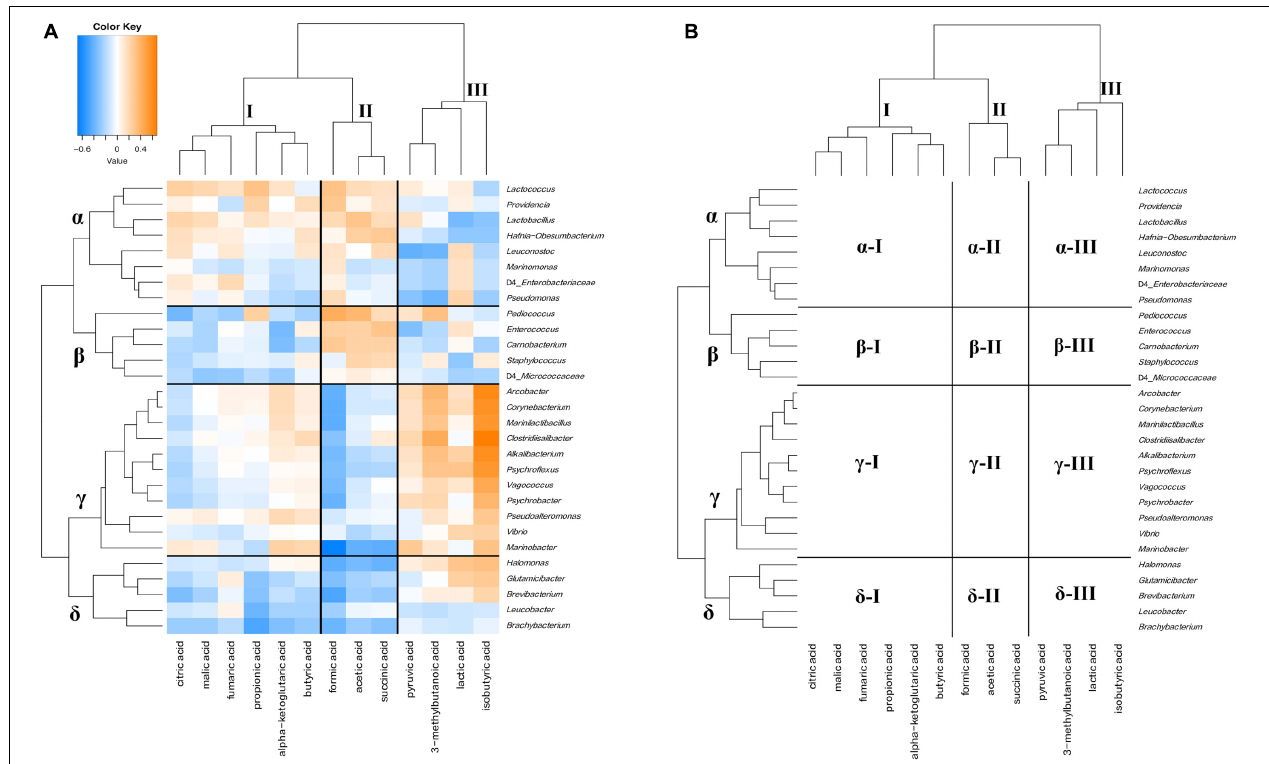
FIGURE 9 | Hierarchical clustered map showing the Spearman correlation between bacteria genus and organic acids detected on 30 cheese samples. (A) Spearman correlation heat map. Orange indicates positive correlation and blue indicates negative correlation. (B) Hierarchically clustered map. Organic acids clusters are represented by I, II, and III. Bacteria clusters are represented by α , β , γ , and δ